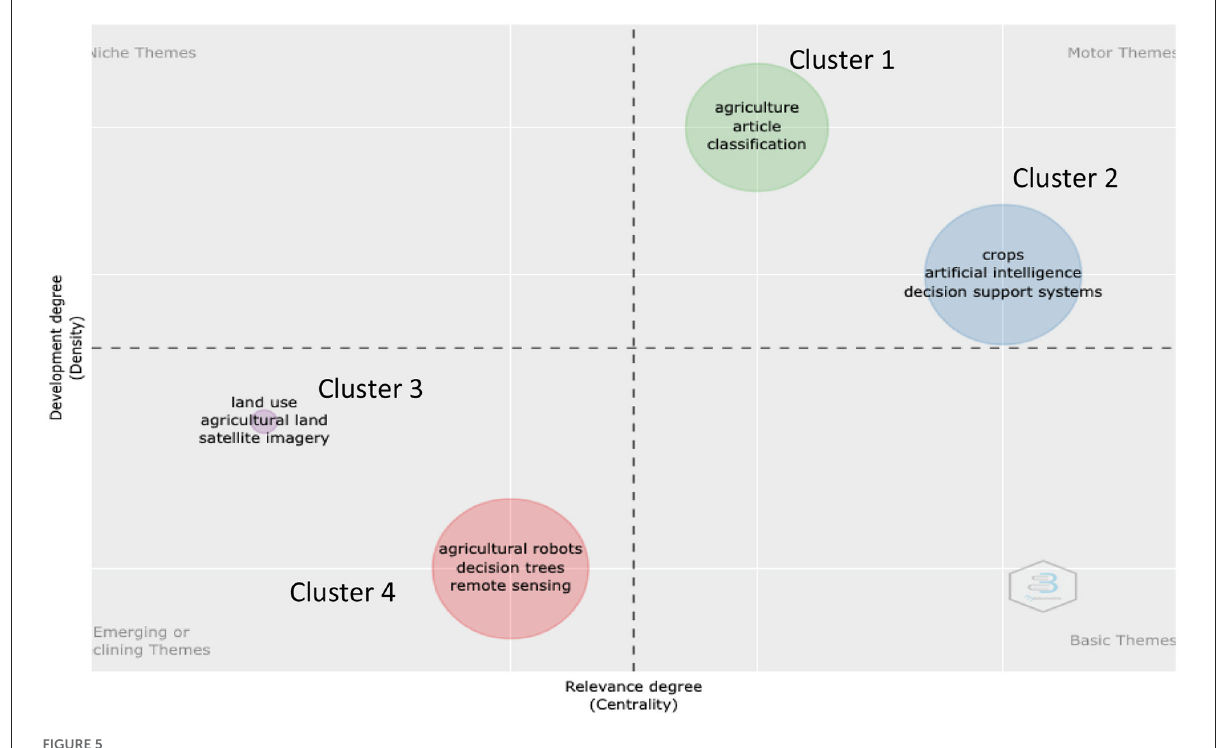
FIGURE5 Thematic